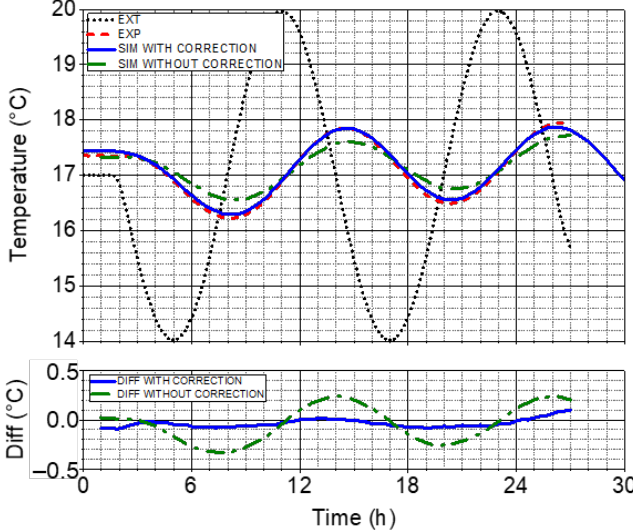
Figure 14. Mean air temperature within the building for the light house configuration.